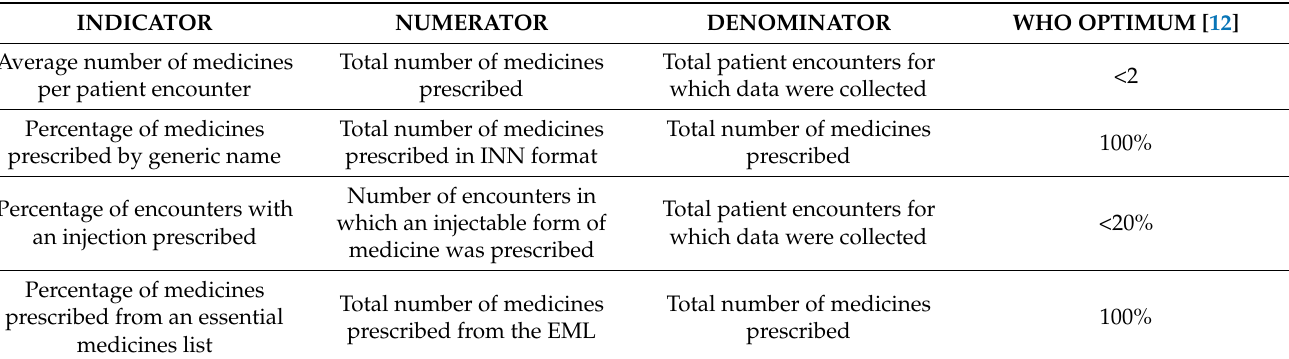
Table 1. Data variables for assessing prescribing indicators among outpatients at University Hospital, KNUST in